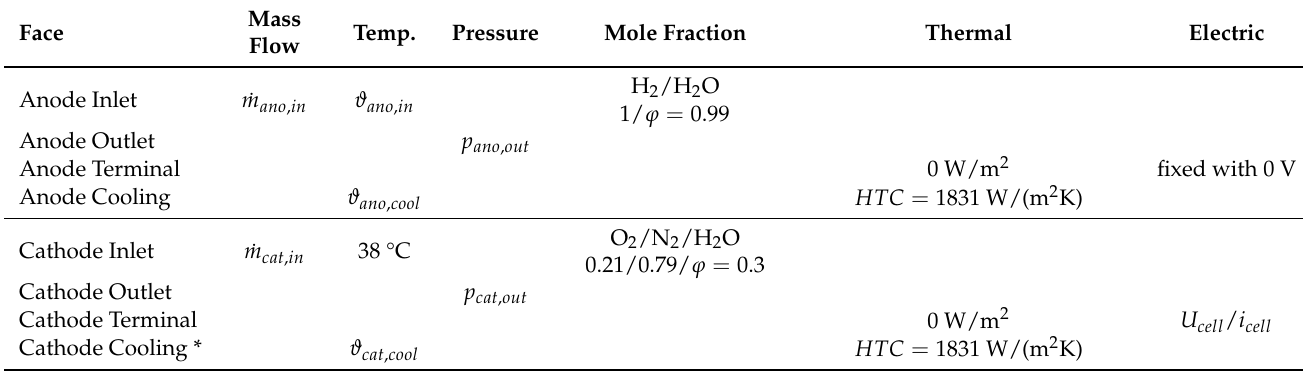
Table 5. Boundary conditions for presented numerical